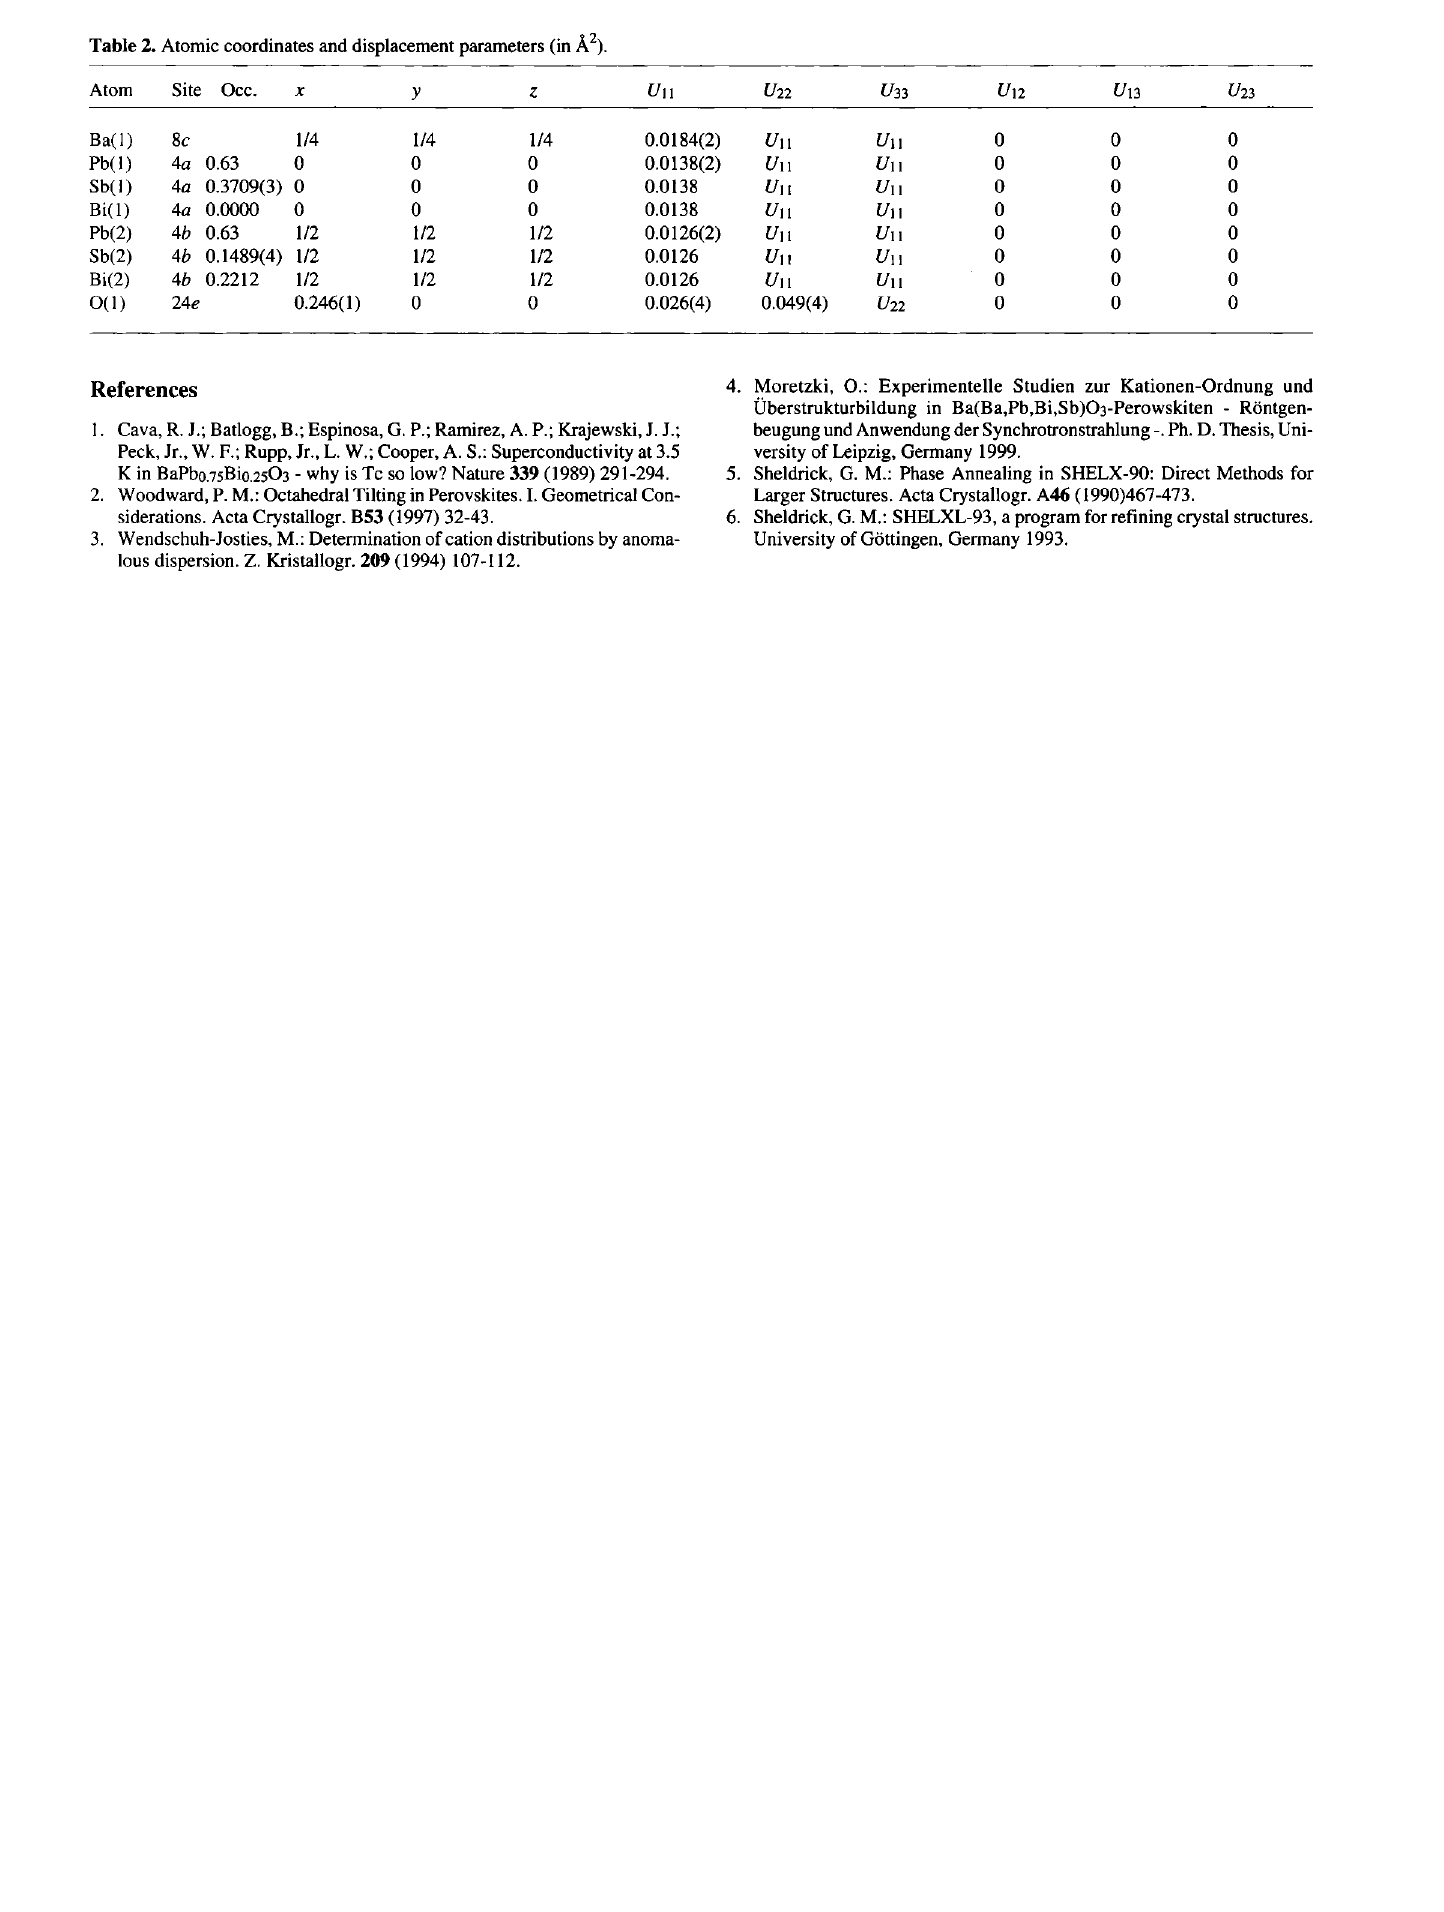
Table 2. Atomic coordinates and displacement parameters (in Ä 2 ).